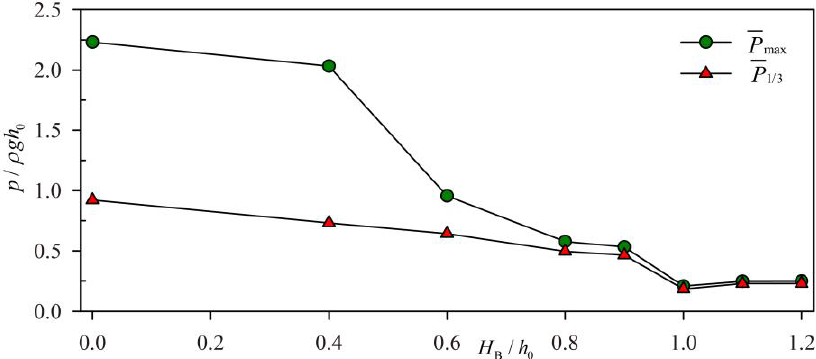
Figure 8. Mean values of maximum pressure and significant pressure at point A with different height baffles ( T = 1.91 s, ω / ω 0 = 1.004).